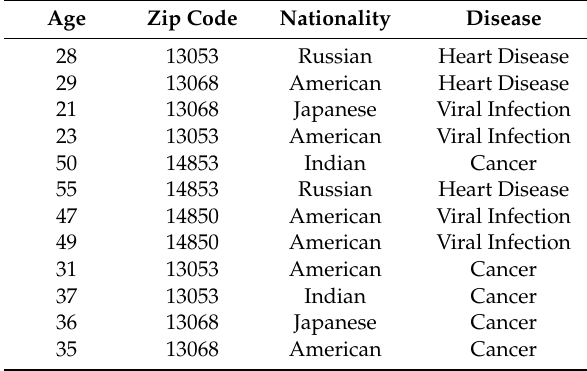
Table 1. A microdata table [3].